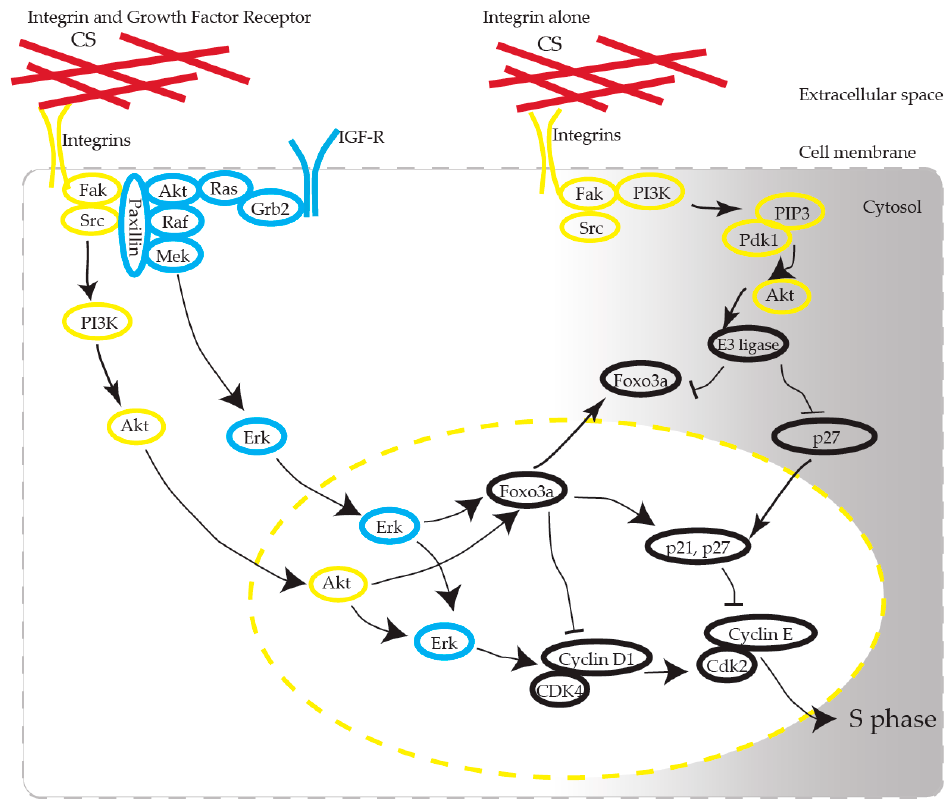
Figure 9. Possible pathways involved in CS-stimulated KF proliferation. CS interacts with integrin, induces AKT activation, and produces cell cycle progression. Note that Erk activation is mandatory for cell cycle progression. Arrows stand for activation; bars represent inhibition.